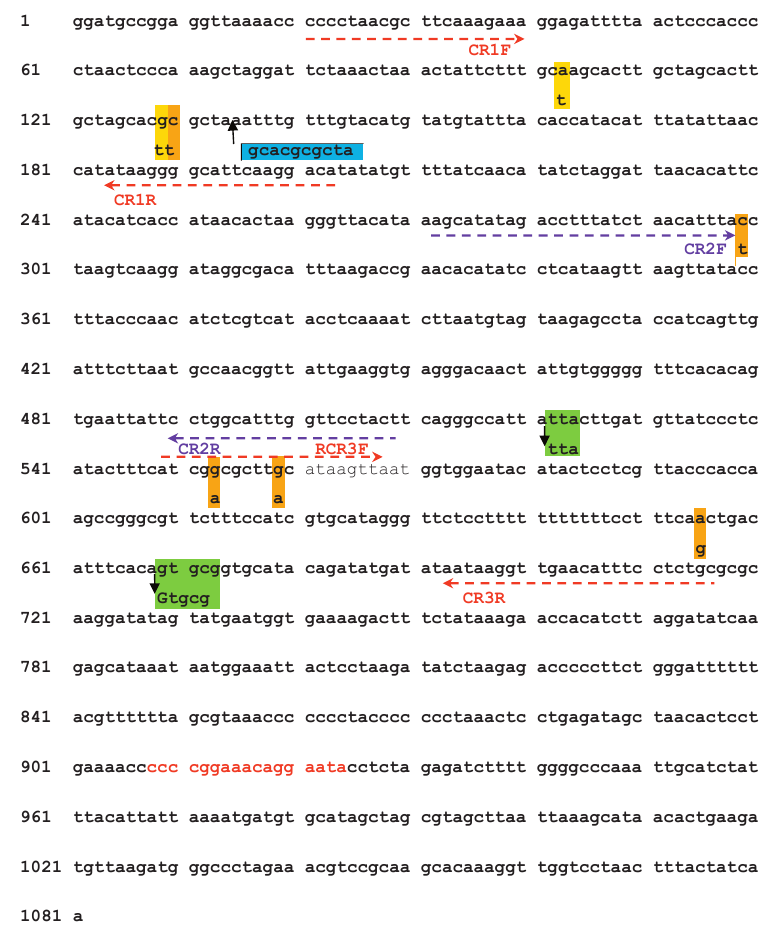
Fig. 1. The sequence of the control region of perch, Perca fluviatilis , mtDNA (GenBank Y14724) with marked mutations detected in the